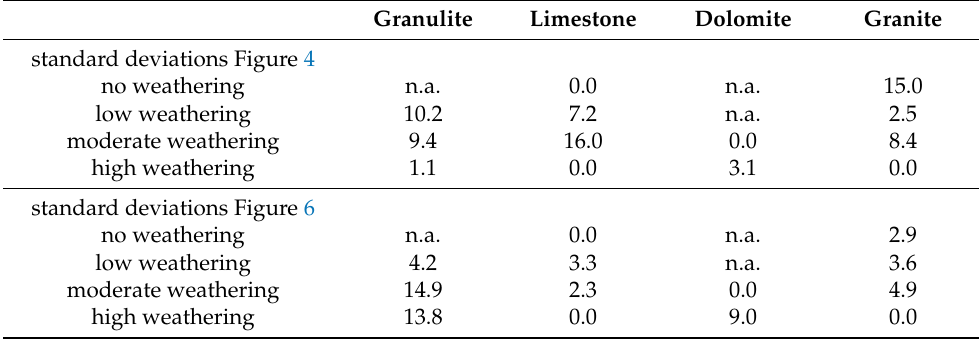
Table 4. Standard deviations for Figures 4 and 6.